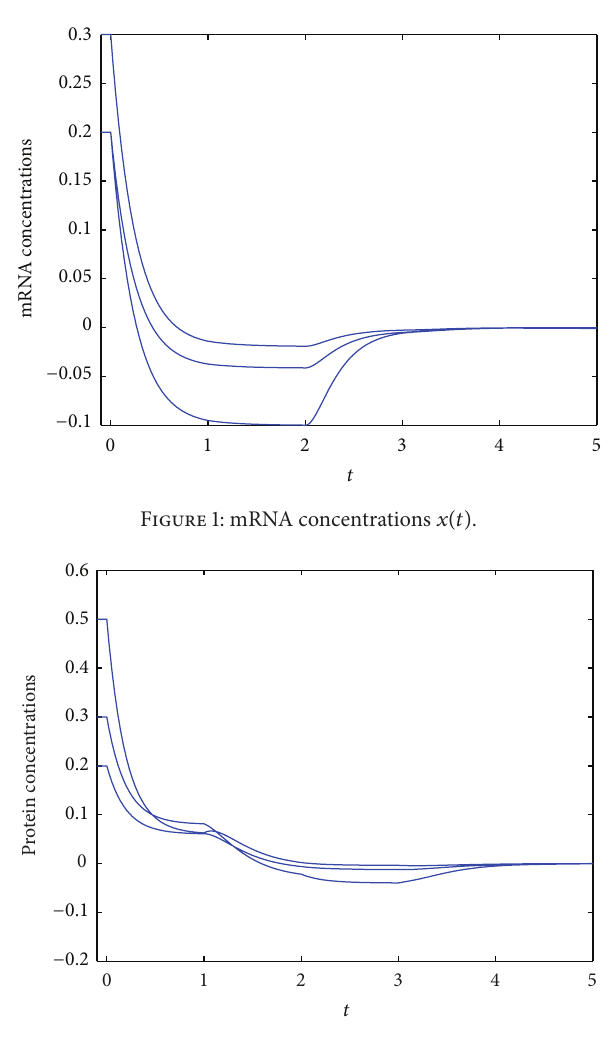
Figure 2: Protein concentrations 𝑦(𝑡)